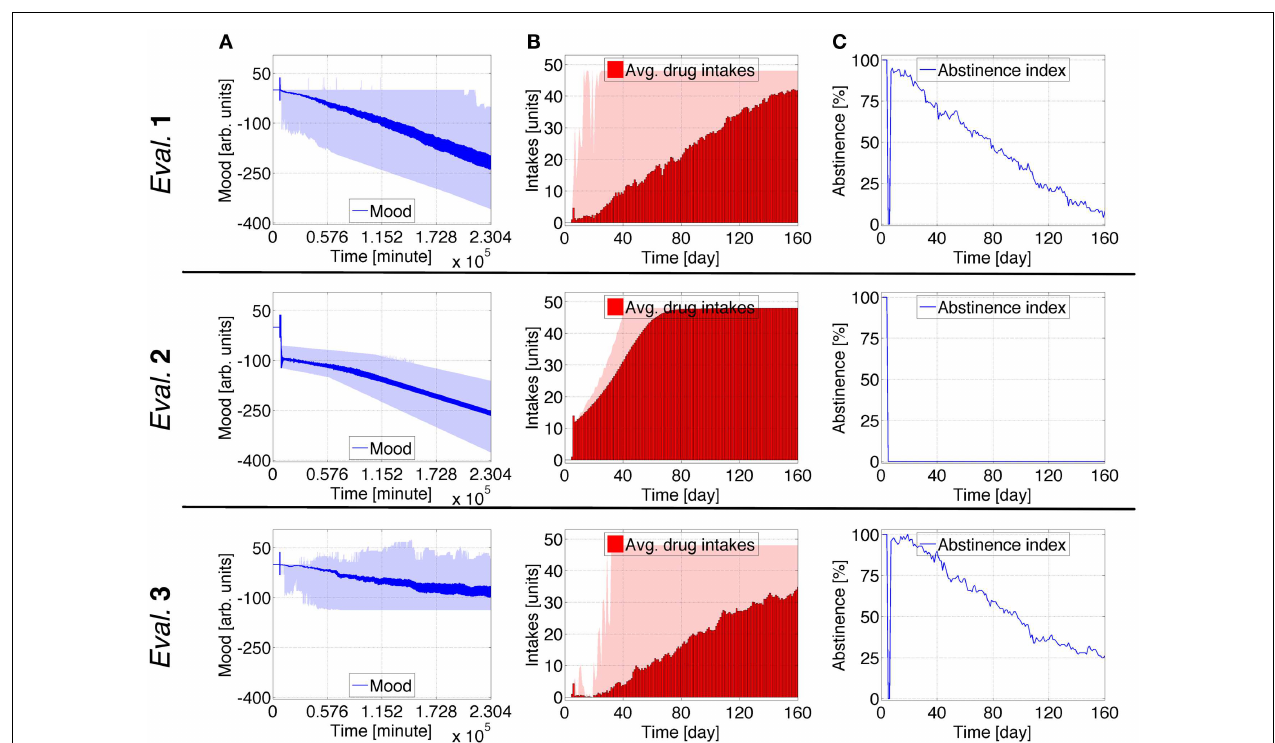
time-dependent and T 0 constant in Evaluation 3. (A) Shows the evolution of the subject’s mood M ; (B) the average number of drug intakes; and (C) the abstinence index.The shades correspond to 95% simulation envelopes.The time-scales are minutes for (A) , and days for (B,C) . Further details of these simulations are reported in FiguresS1 and S2 in Supplementary